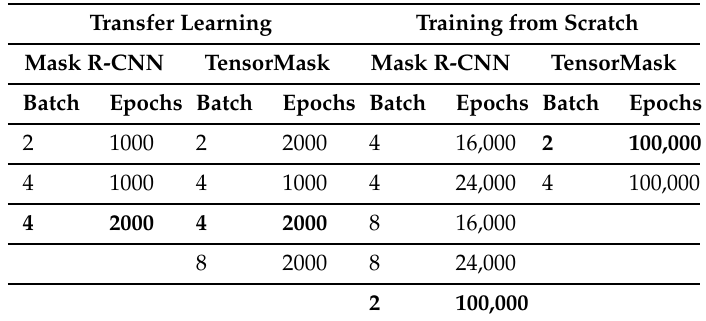
Table 1. Training parameters that achieved the best results in training.